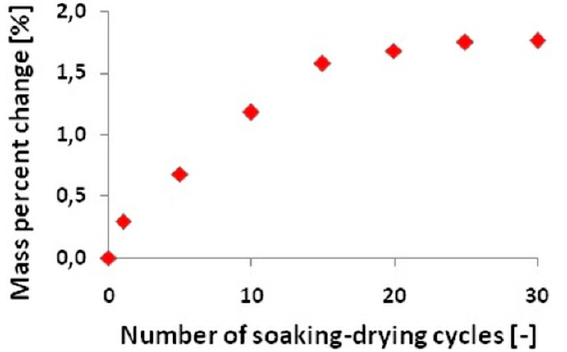
Figure 1. Percentage change as a function of the number of soaking–drying cycles.